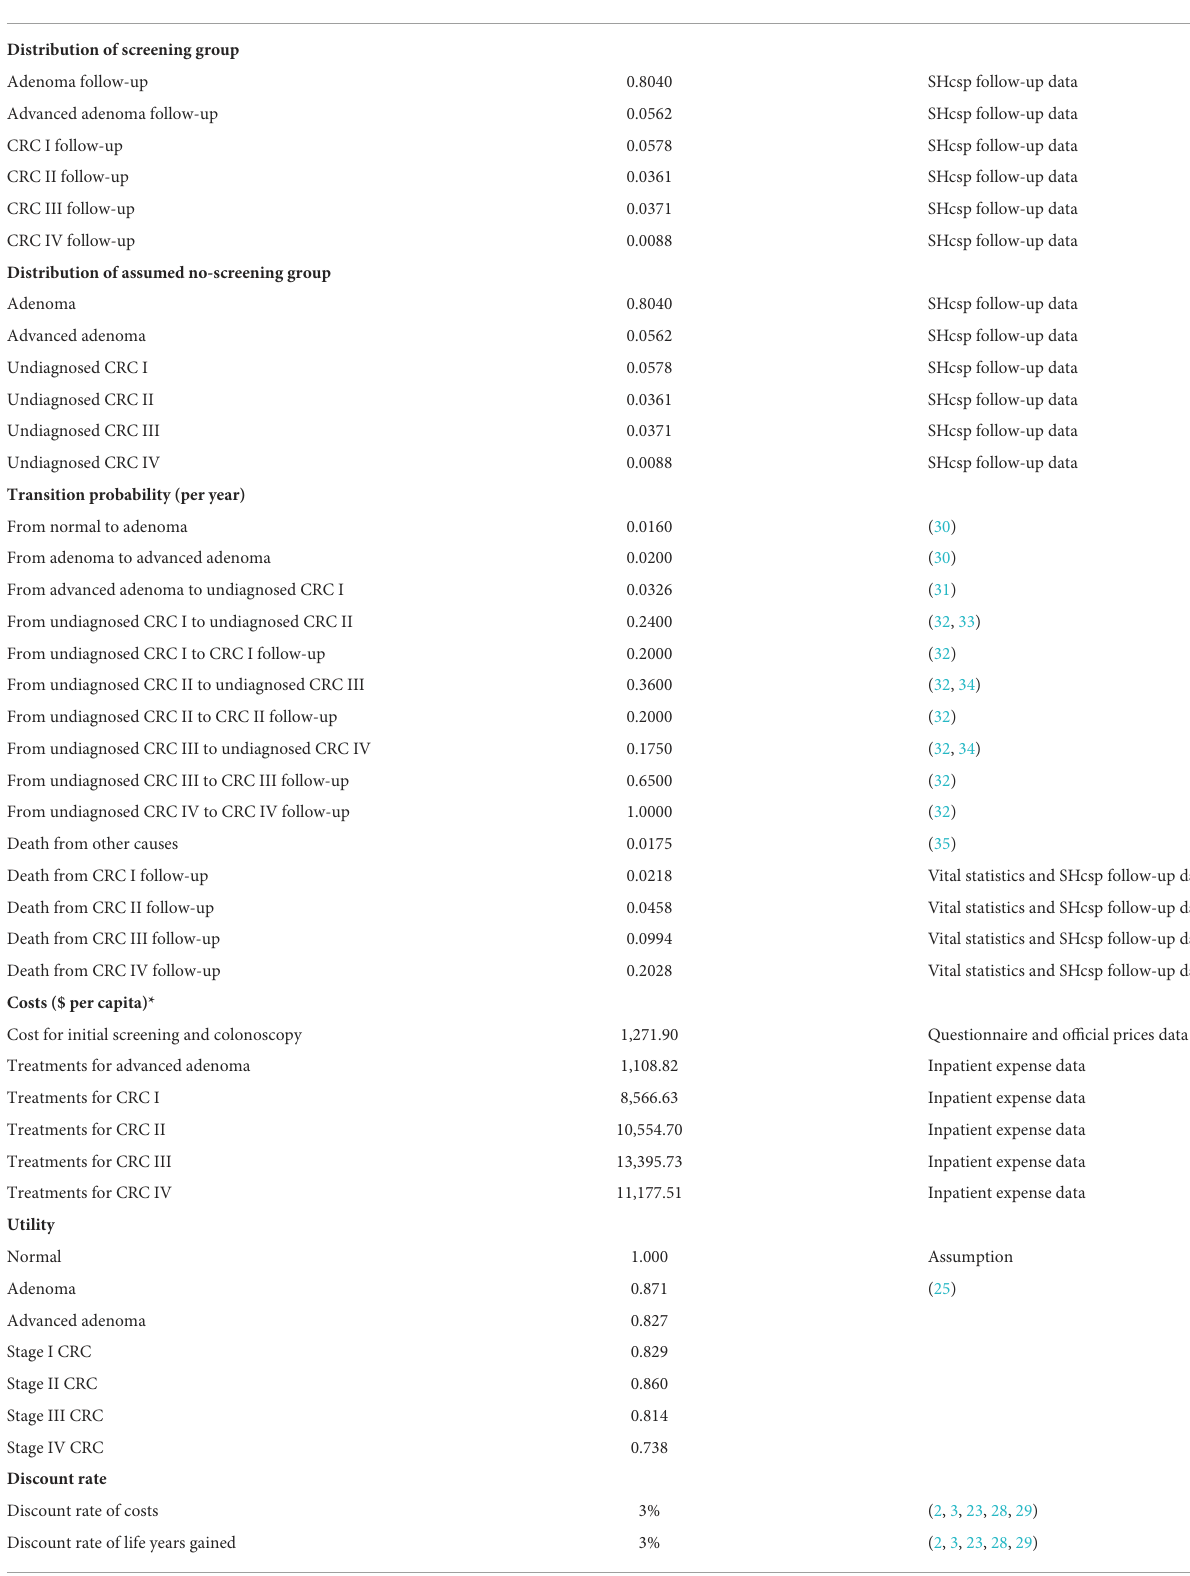
TABLE 1 Parameters of the Markov model for